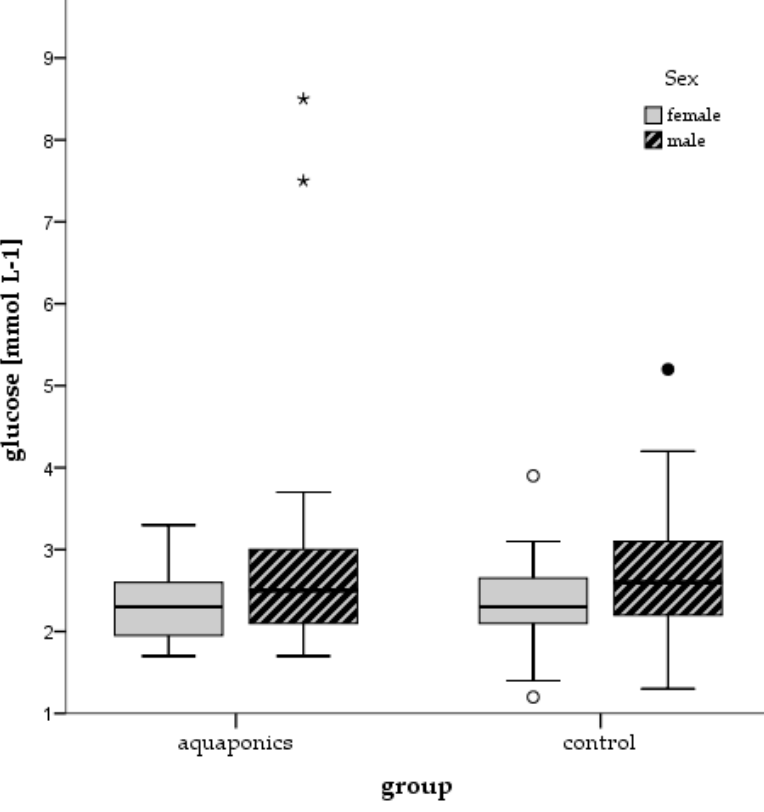
Figure 13. Blood glucose levels of African catfish ( C. gariepinus ) in different cultivation groups, subdivided by genders. Illustrated is the sampling in small groups over the entire experiment. Outliers: ○ / ● ; extrem values: *.